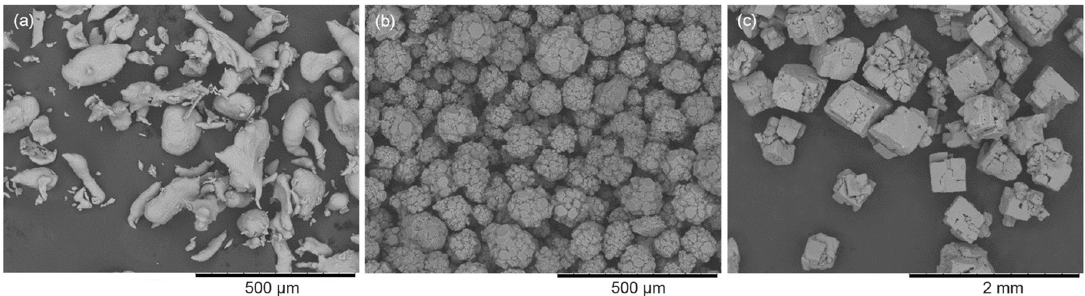
Figure 1. The as-utilized powder ( a ) the pure Al powder, ( b ) the Al 2 O 3 powder, ( c ) the NH 4 Cl